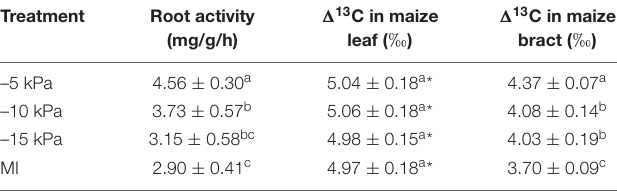
TABLE 3 | Effects of different treatments on root activity and (cid:49) 13 C of maize. Treatment